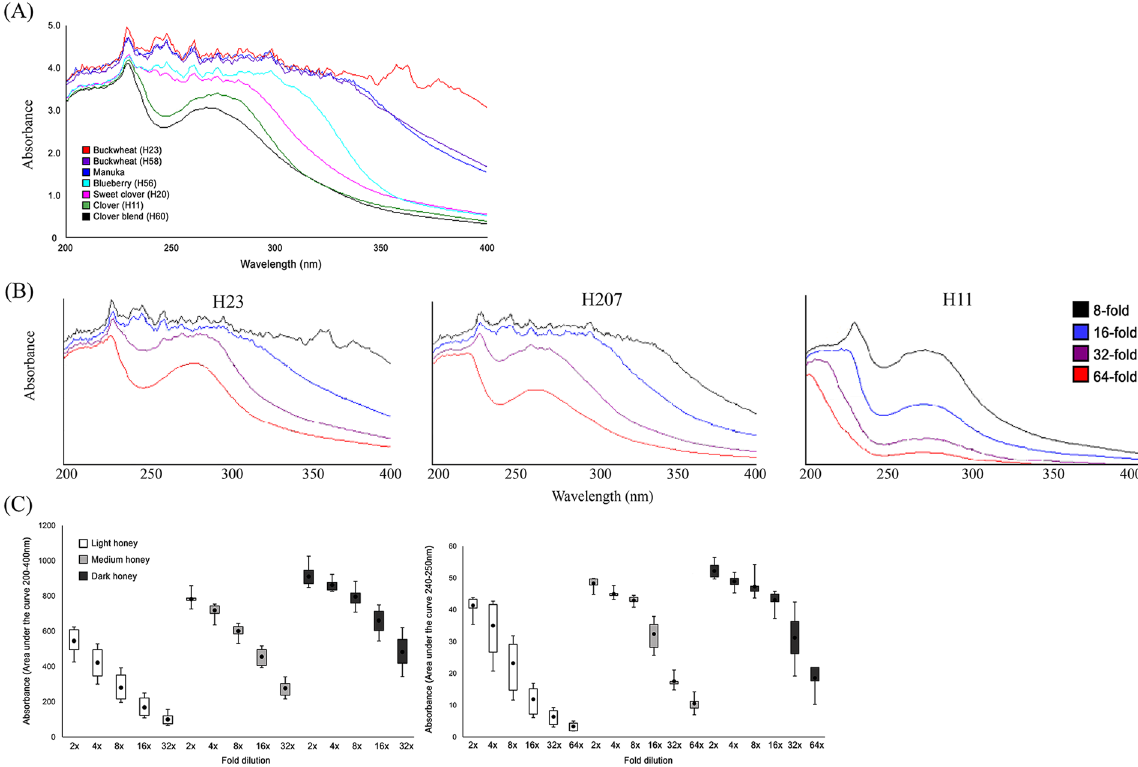
Figure 1. UV extinction spectra at 200 to 400 nm range of different honeys at 8-fold dilution ( A ), changes in the shape and magnitude of spectral profiles of dark (H23, buckwheat), medium (H207, canola/willow blend) and light (H11, clover) honeys upon 8 to 64-fold dilution ( B ), the non-linear rate of decrease of the AUC 200–400 nm and AUC 240–250 nm in medium (grey boxes) and dark honeys (black boxes) as oppose to in light honeys (open boxes) upon